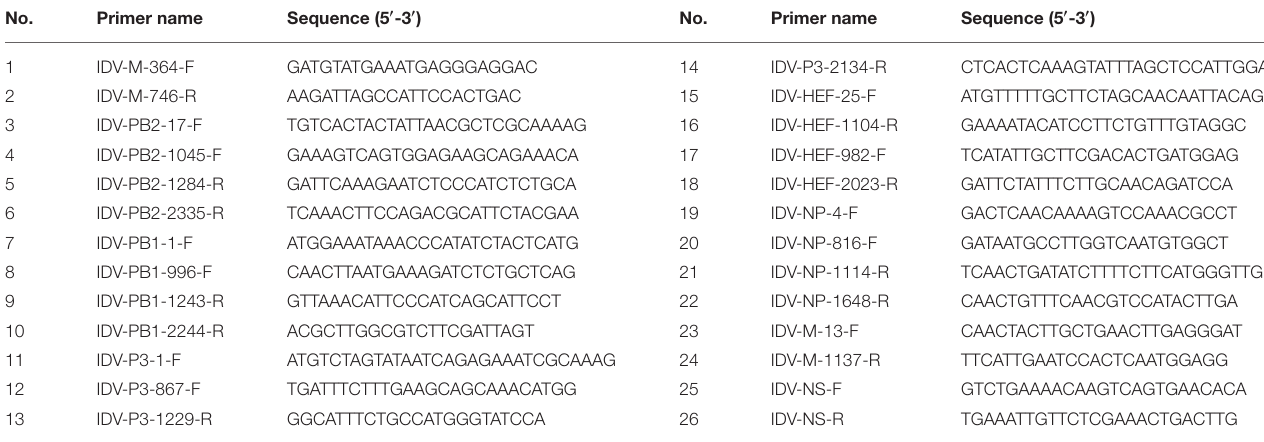
TABLE 1 | Primers used in this